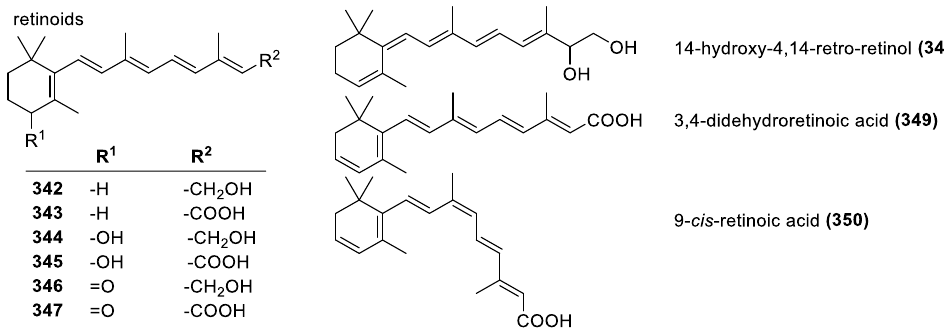
Figure 24. Structure of common natural retinoids.